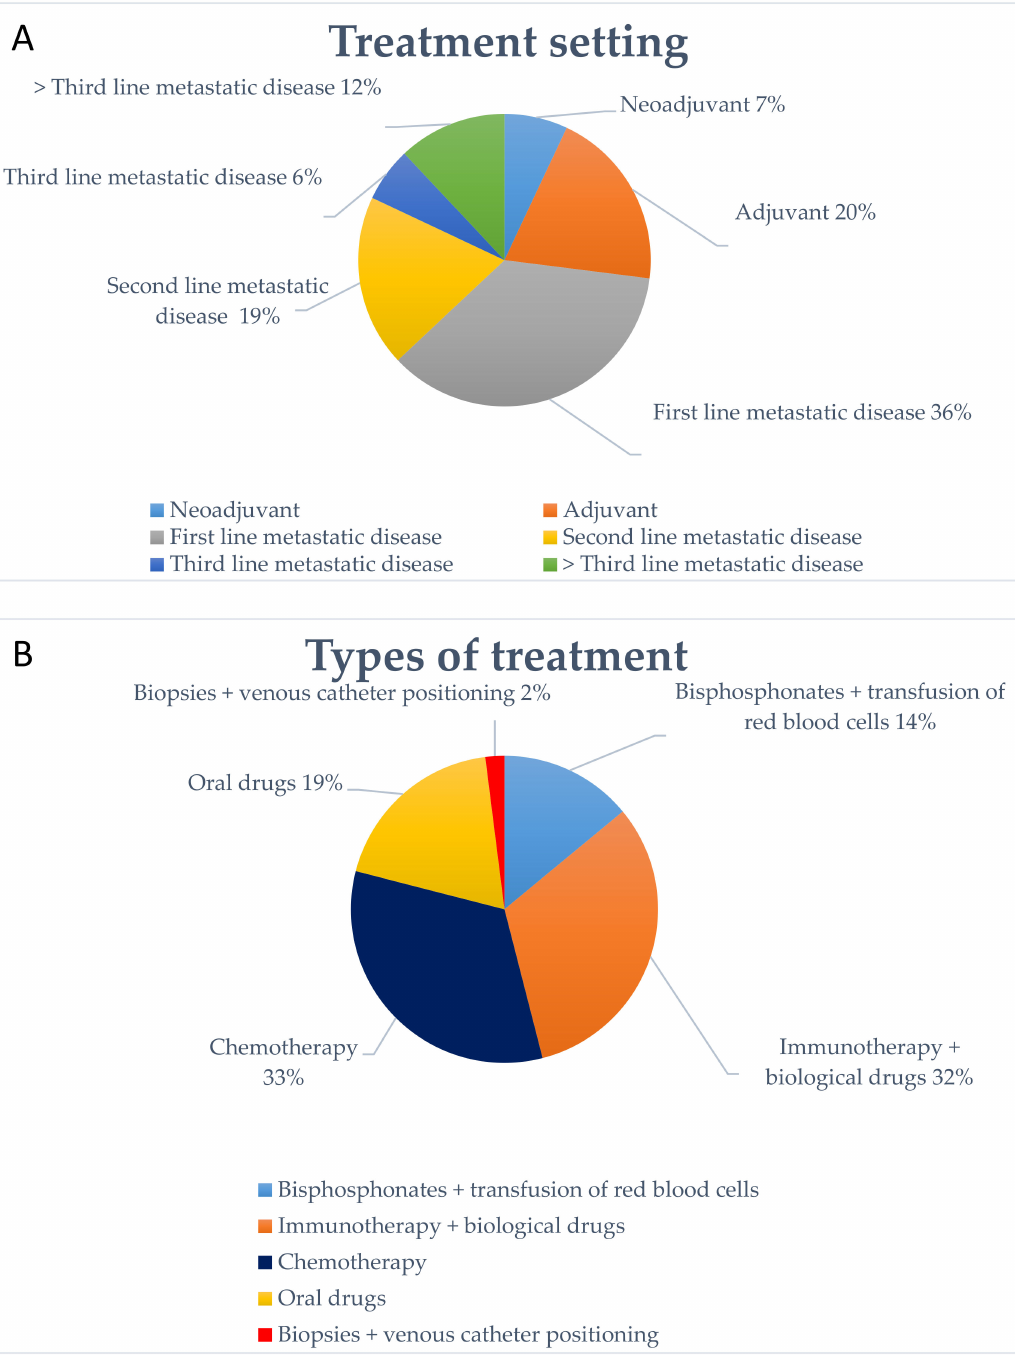
Figure 5. The image shows the type of treatment performed by patients ( A ) and patients’ setting of treatment in 2020 ( B